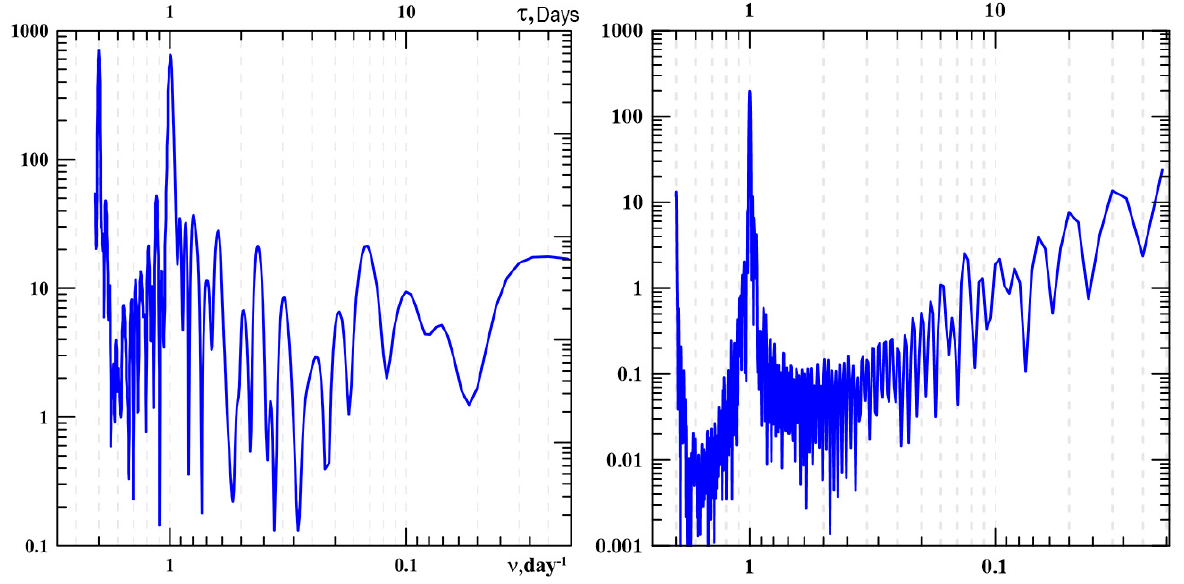
Figure 1. The spectrum of the critical frequency f 0 F 2 in Peterhof in a sliding 60-day time interval, centered on 31 January 2019 ( left ), and the corresponding spectrum of temperature fluctuations at an altitude of 200 km according to the MUAM model data ( right ). The lower axis is the frequency (1/day), and the upper axis is the period in days.